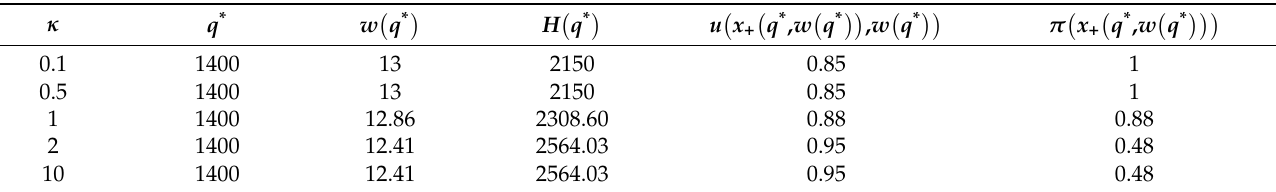
Table 4. Solutions of the proposed model with ϕ = 2 .